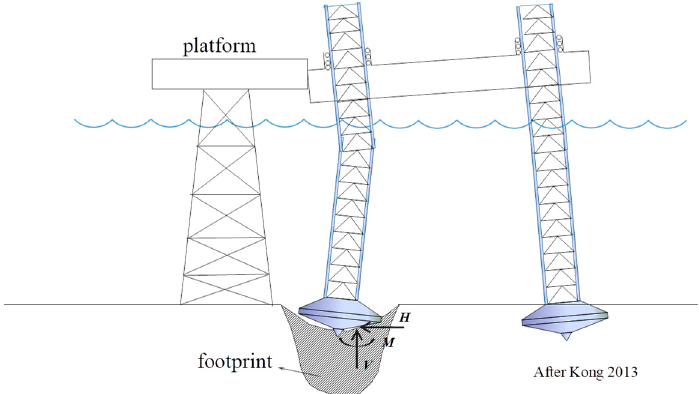
Figure 1. The failure mechanism of spudcan reinstallation near a footprint.